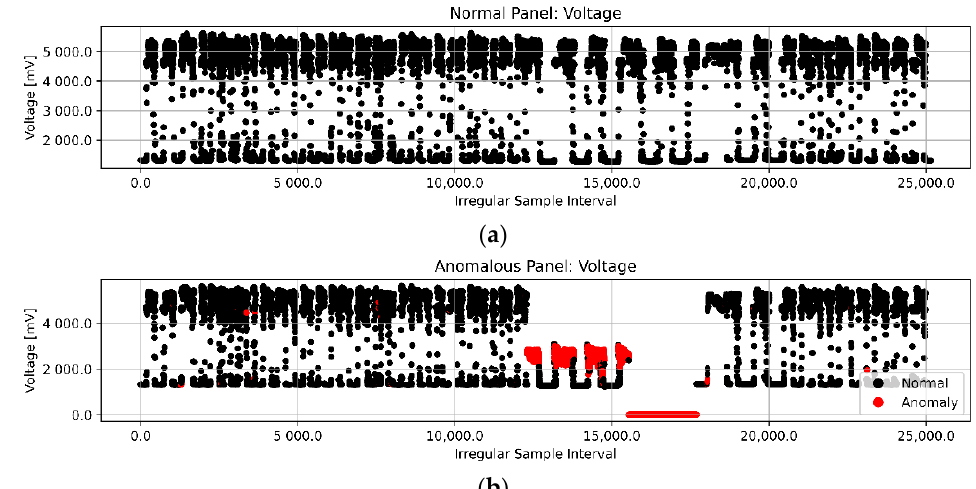
Figure 8. Initial voltage data plots: ( a ) normal and ( b ) anomalous.